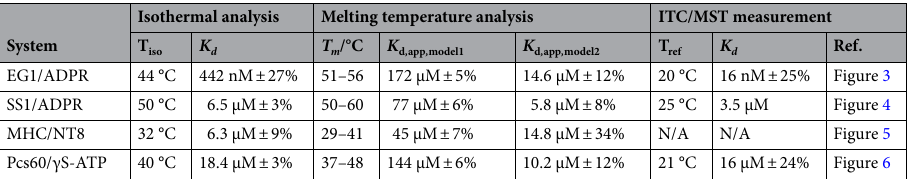
Table 2. Proof-of-principle studies of isothermal analysis of nDSF data. K d were determined from nDSF data by isothermal analysis at the selected temperature. The change of heat capacity upon protein unfolding (∆C p ) was assumed to be zero for all nDSF analyses. A melting temperature analysis with a single-site model [model 1, Eq. (1)] and an alternative model [model 2, Eq. (4)] was used to determine apparent binding affinities K d,app